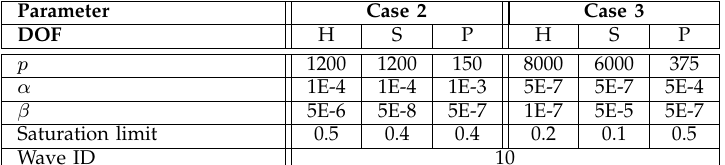
TABLE IV: Parameters for weight adjustment (Eq. 23 by controller objective case